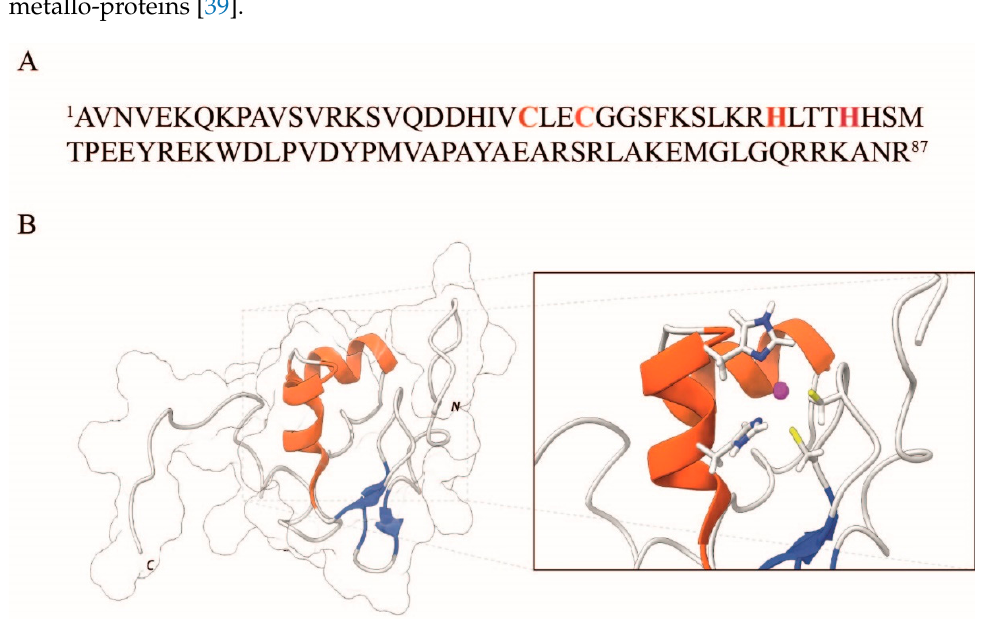
Figure 1. ( A ) Amino acid sequence of Ros87. The coordinating residues are highlighted in red. ( B ) NMR representative structure of Ros87 (PDB ID: 2JSP), realized using the software Chimera [40] . The secondary structure elements are depicted in red ( α -helix) and blue ( β -strands). A close view of the side chains of coordinating residues is shown in the inset.